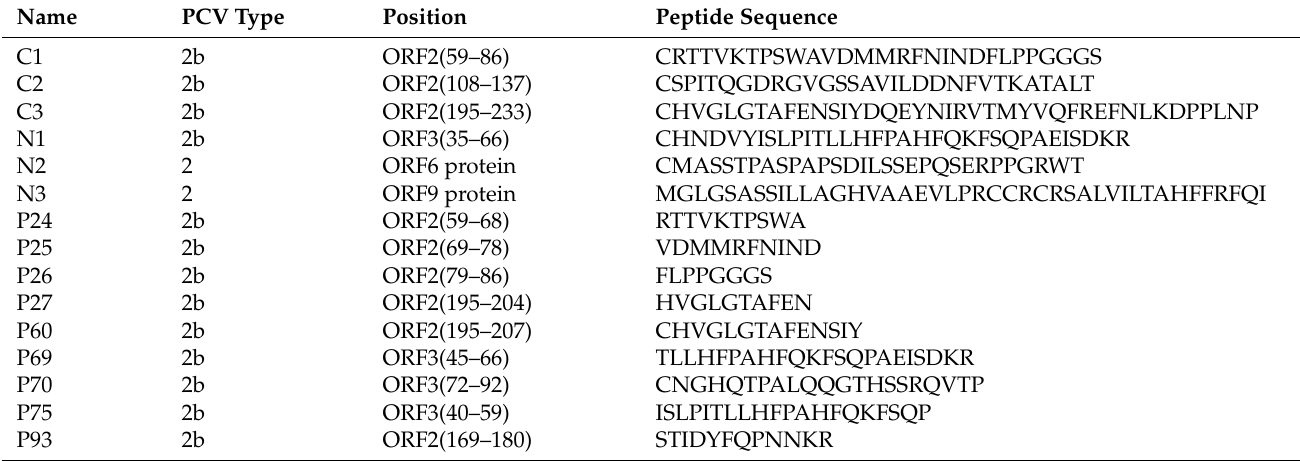
Table 2. Peptide sequences of the ORF proteins of